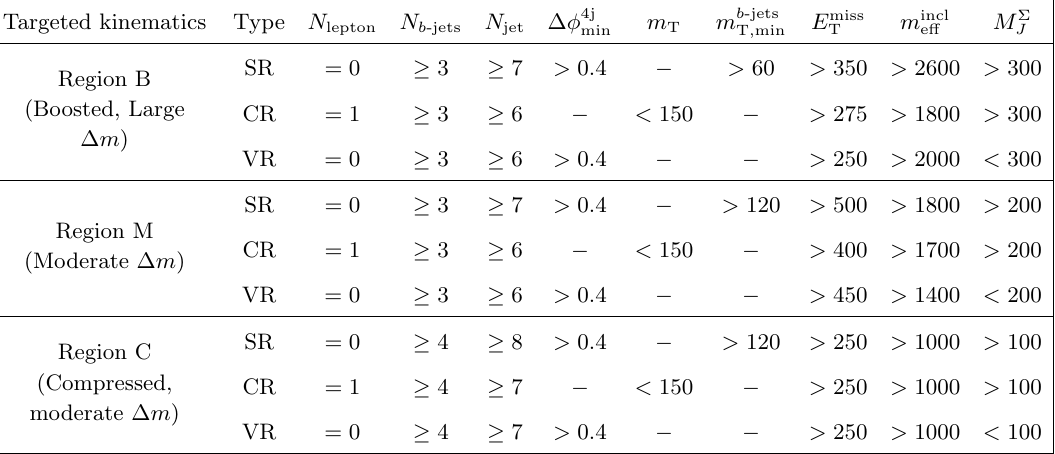
Table 2. De(cid:12)nitions of the Gtt SRs, CRs and VRs of the cut-and-count analysis. All kinematic variables are expressed in GeV except (cid:1) (cid:30) 4j , which is in radians. The jet p T requirement is also min applied to b -tagged jets.